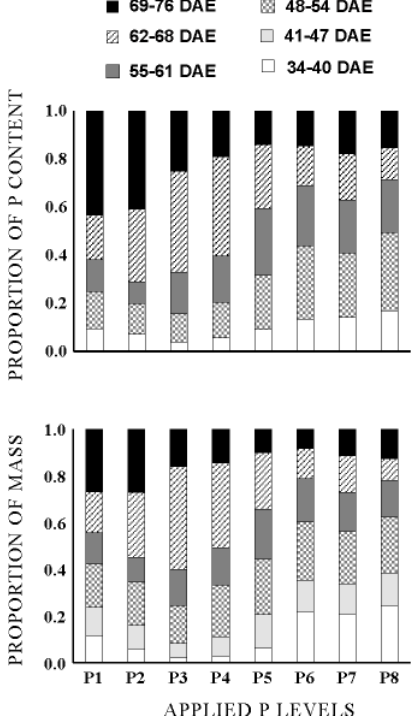
Figure 4. Proportion of dry mass and P accumulated in senesced leaves at each week of growth, relative to total dry mass and P accumulated in senesced leaves throughout the growth cycle, of common bean plants grown at eight P levels applied to the soil (in mg kg -1 P): P1 5, P2 10, P3 20, P4 40, P5 80, P6 160, P7 320 P8 640; DAE: days after